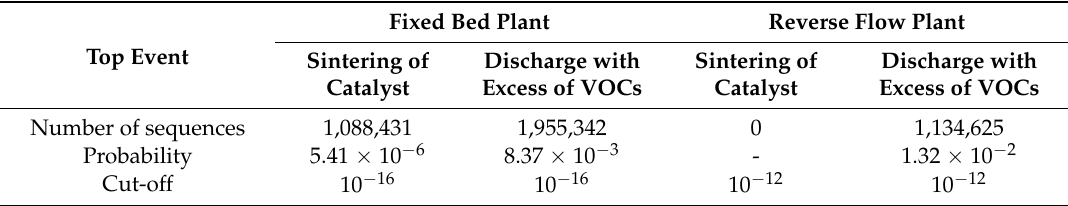
Table 1. Results of the logical–probabilistic